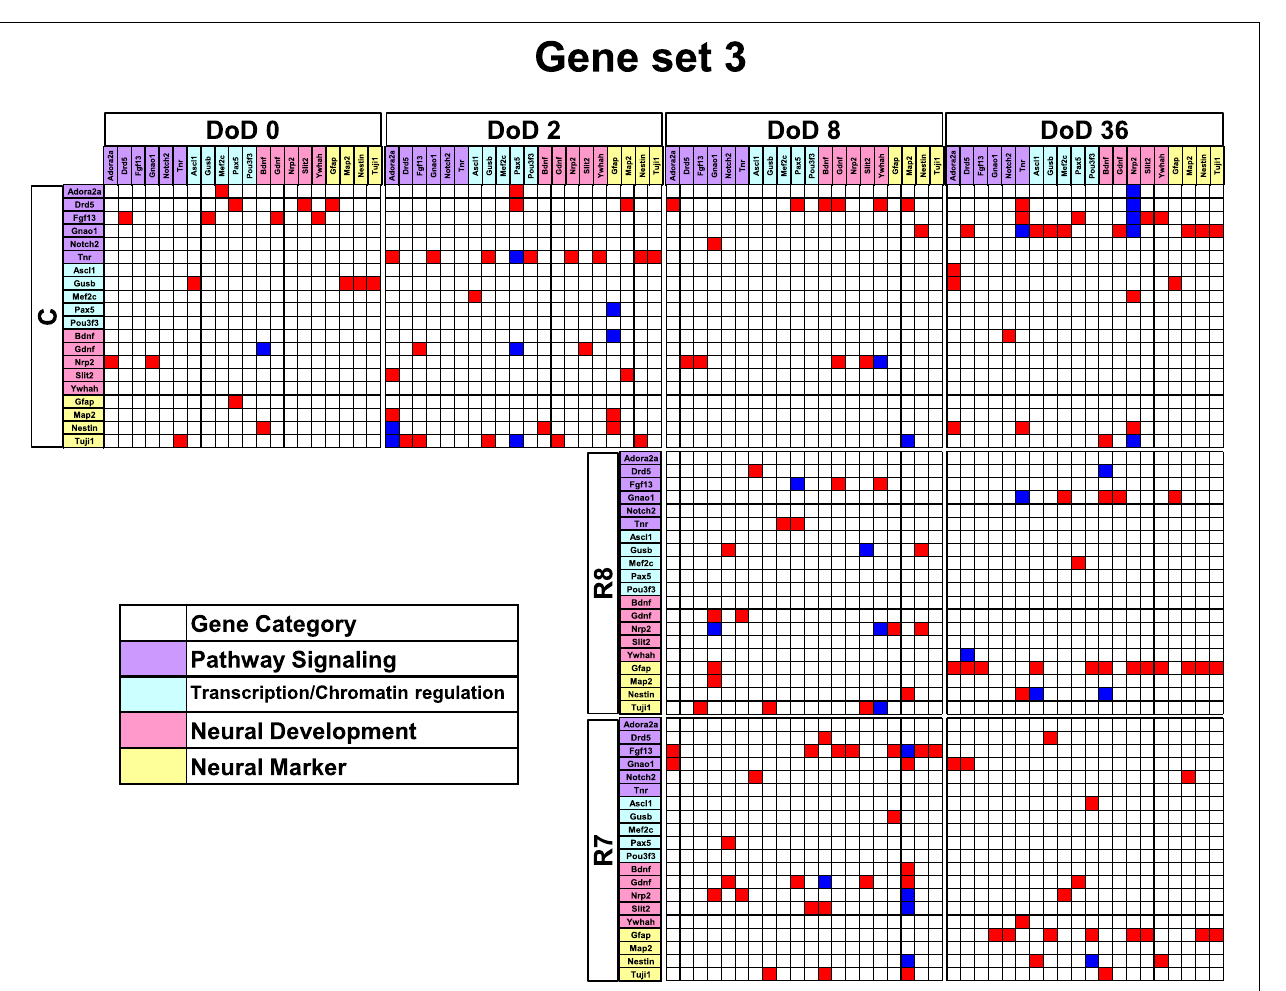
indicates up regulated genes and blue indicates down regulated genes. Red indicates that genes from the y axis up regulated genes from the x axis. Blue indicates that genes from the y axis down regulated genes from the x axis. Symbols of C, R8, and R7 indicate vehicle control, RA 10 − 8 M, and RA 10 − 7